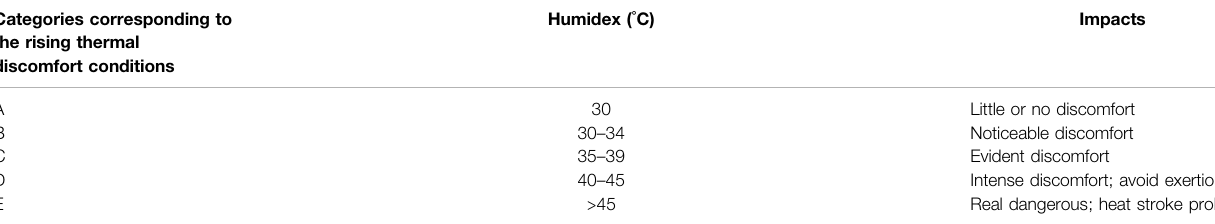
TABLE 3 | Humidex threshold and potential health impact.